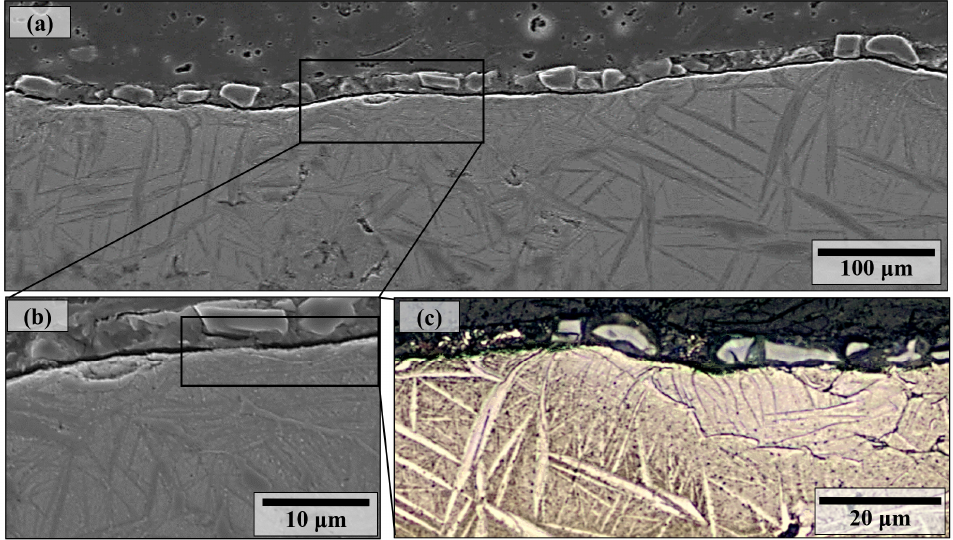
Figure 15. Cross-sectional SEM ( a , b ) and optical images ( c ) of wear affected zone in unpeened Cp-Ti samples at sliding distance of 600 m.